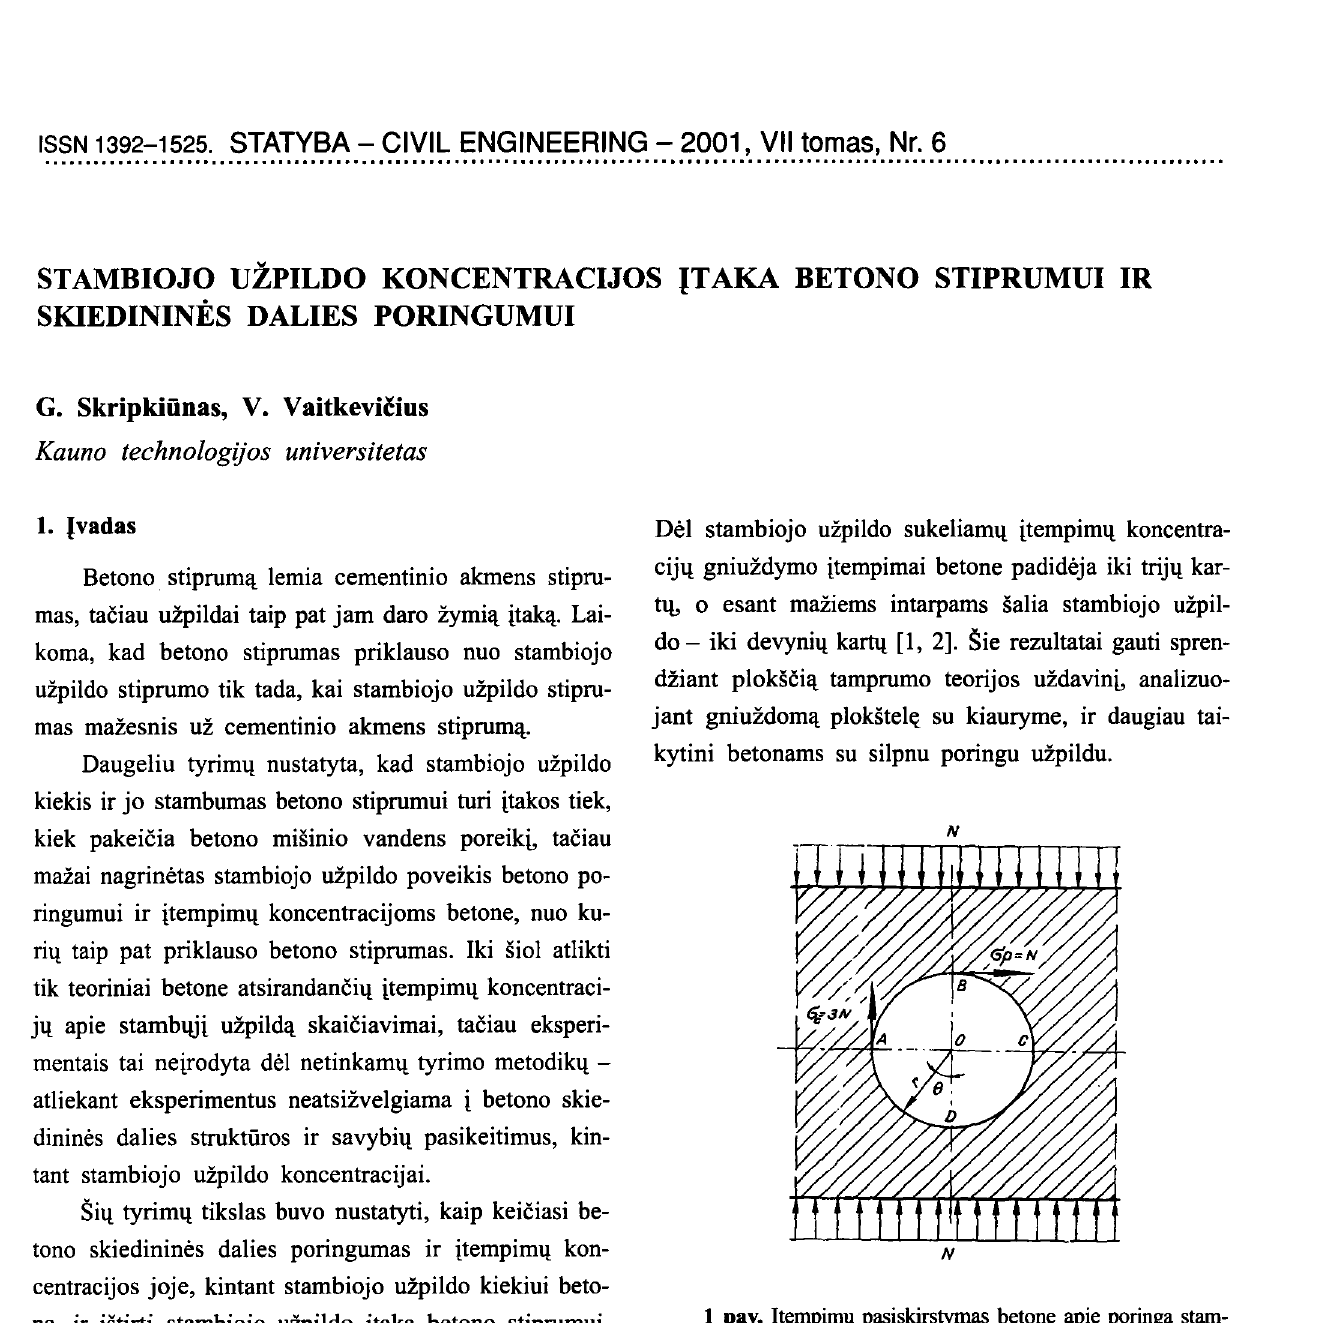
Fig 1. Distribution of stresses in the concrete near po rous coarse aggregate Minetus samprotavimus patvirtina ir I. N. Achver dovo atlikti eksperimentai, naudojant ploksCius mode lius su optiskai jautrios medZiagos matrica ir U.Zpildais is cementinio akmens. Poliarizaciniu-optiniu metodu